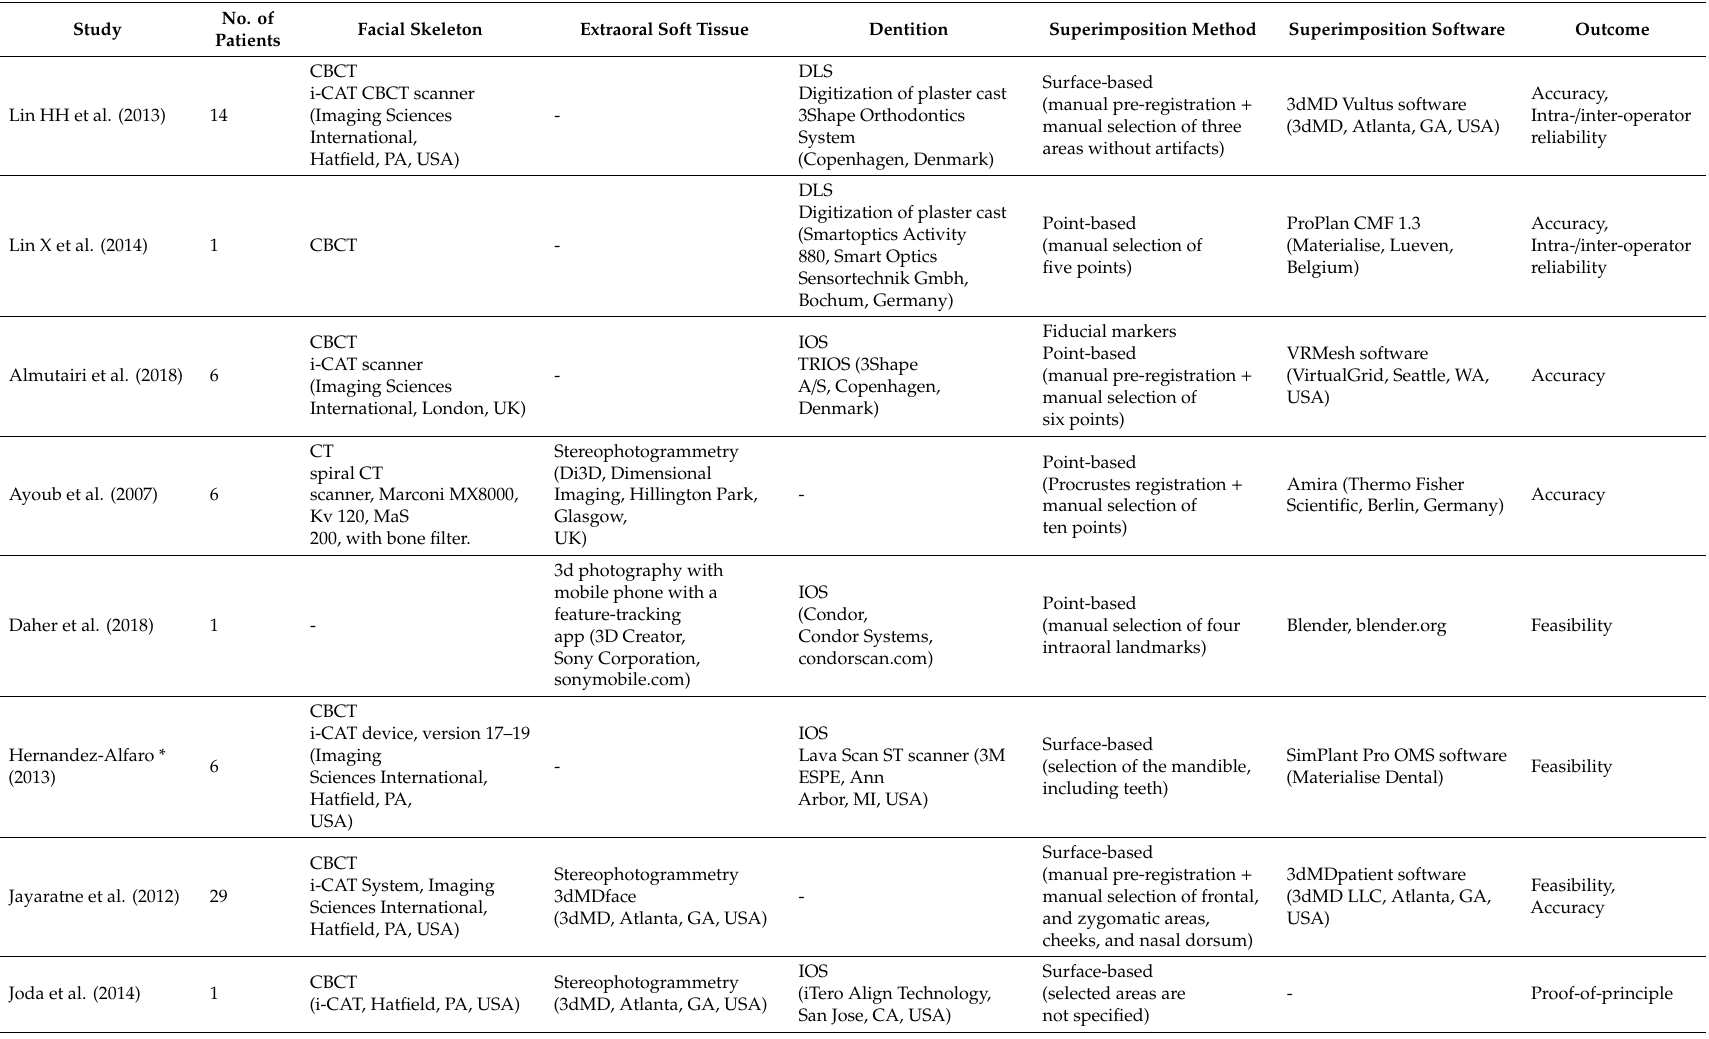
Table 1. Information on the included